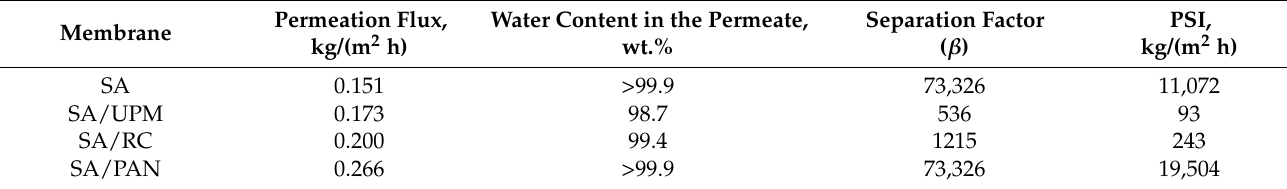
Table 2. Transport properties of the dense SA membrane and supported membranes with a thin layer based on SA, deposited on various porous substrates (UPM, RC, and PAN), in the pervaporation separation of an azeotropic water/isopropanol (12/88 wt.%) mixture at 22 ◦